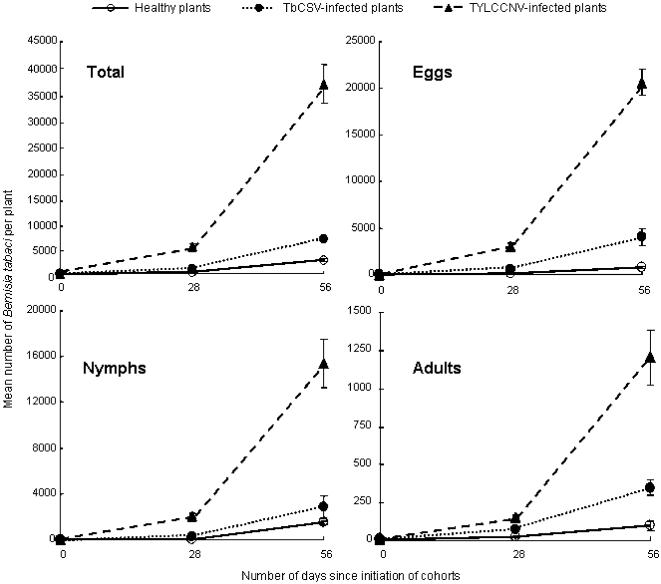
Mean numbers (±standard error) of eggs, nymphs, adults or all individuals per plant at two sampling dates of three cohorts of the B biotype Bemisia tabaci that were initiated on healthy, TbCSV-infected, or TYLCCNV-infected tobacco plants. Each plant was inoculated with 5 female and 5 male adult whiteflies.